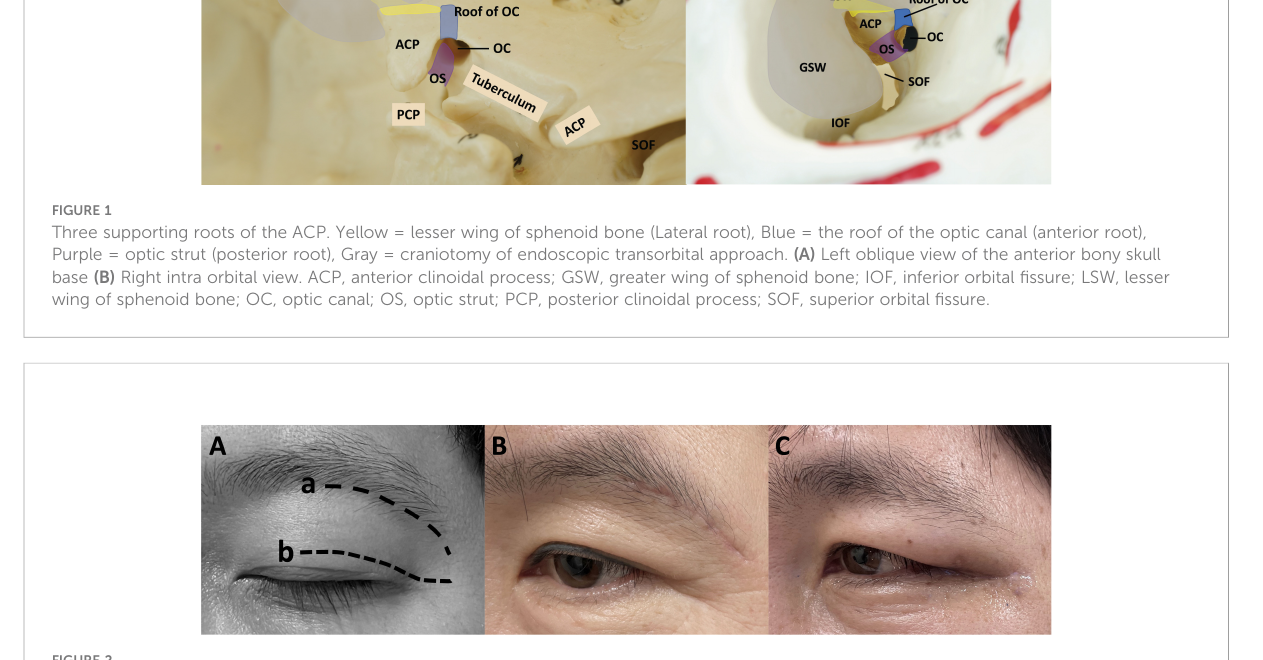
FIGURE 2 (A) Comparison of skin incision using a; below-the-eyebrow technique and b; transeyelid technique. (B, C) Postoperative patient photographs showing aesthetic results 1 month after ETOA surgery using each technique. B; below-the-eyebrow technique, C; below-the-eyebrow technique. ETOA, endoscopic transorbital